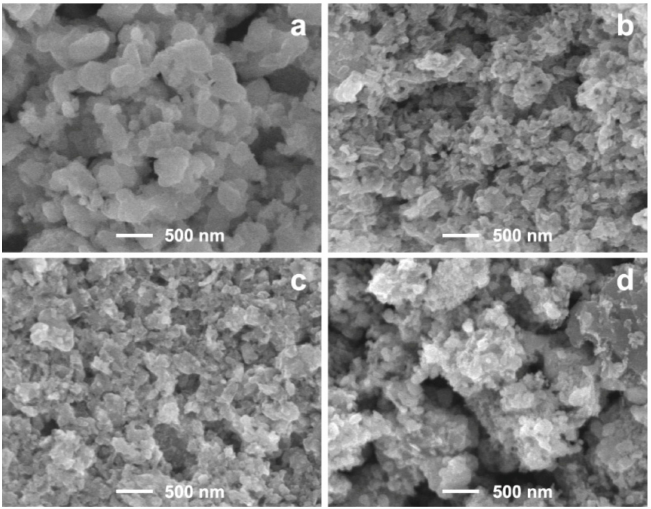
Figure 5. SEM images of LiMnBO 3 prepared by ball-milling the raw materials with ( a ) no carbon, ( b ) PVP, ( c ) sucrose and ( d ) starch in